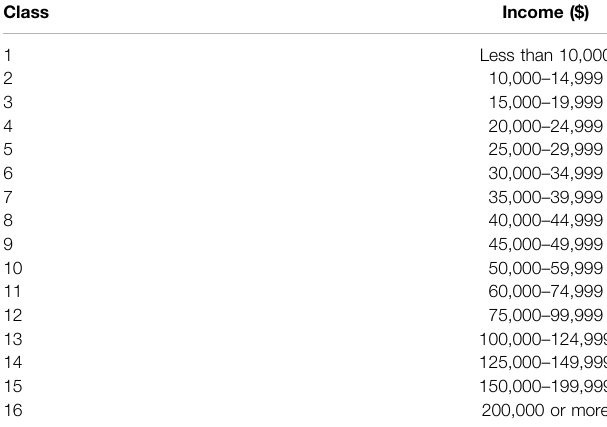
TABLE 1| Incomerange(inUSdollars)correspondingtoeachcategory(orclass).